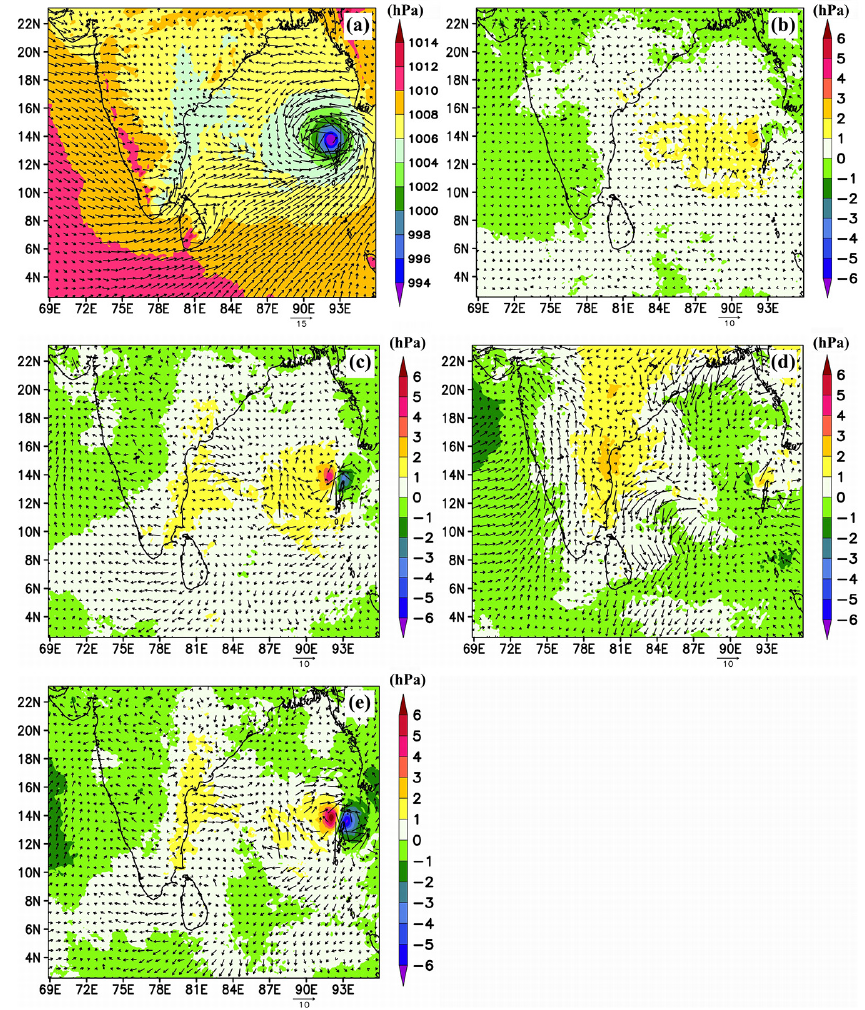
Figure 4. Field of (a) initial sea level pressure (shaded), surface (10m level) wind flow pattern in CTL and analysis difference (VAR − CTL) in (b) VARAMV, (c) VARPREP, (d) VARRAD and (e) VARPREP + RAD for Phailin at 12:00UTC 9 October